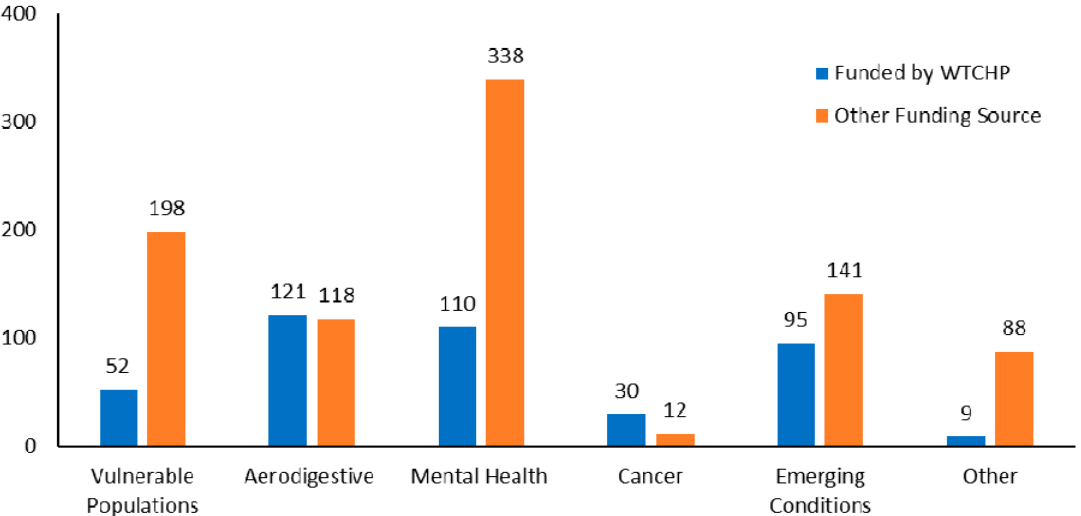
Figure 2. Publication counts by funding source and focus area. Some articles address multiple focus areas (i.e., count sum > 944).